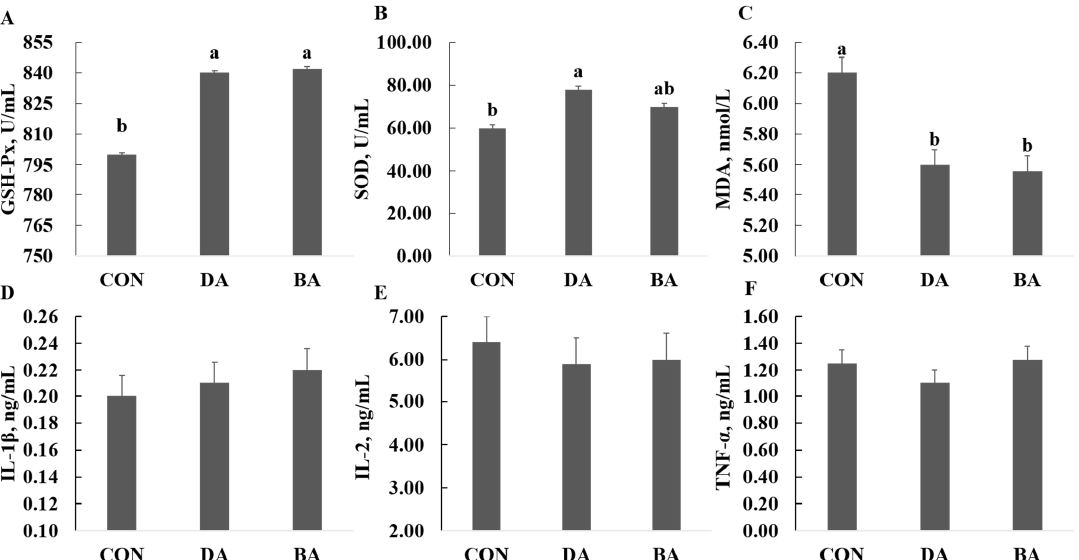
Figure 3. Effects of sodium decanoate and sodium butyrate on serum antioxidant and immune parameters in C57BL/6 mice (Exp. 2). ( A ) Serum GSH-Px. ( B ) Serum SOD. ( C ) Serum MDA. ( D ) Serum IL-1 β . ( E ) Serum IL-2. ( F ) Serum TNF- α . A total of 36 mice with weaning age of 28 d were allocated into three dietary treatments randomly, which are control (CON), 5 g/kg sodium decanoate (DA), and 5 g/kg sodium butyrate (BA) diets. At the end, the blood sample from each mouse was collected to evaluate antioxidase activity and inflammatory cytokines levels. a,b Significant differences are indicated by different lowercase letters ( p < 0.05), n = 6.